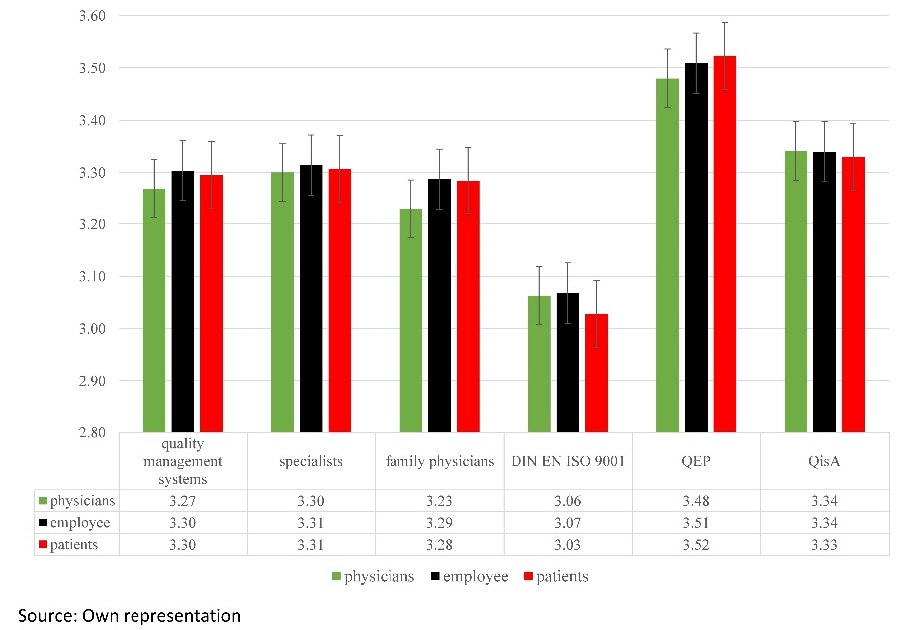
Figure 2. Average scores of questionnaire groups. Figure 2 shows the average scores of quality management systems for the individual survey groups. The questionnaires feature scores from one to four, with four (very good) being the highest and one the lowest (very poor) score. No significant deviations could be detected.